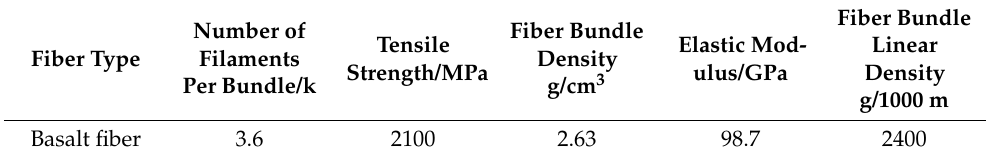
Table 2. Mechanical performance parameters of epoxy-impregnated fiber bundle.